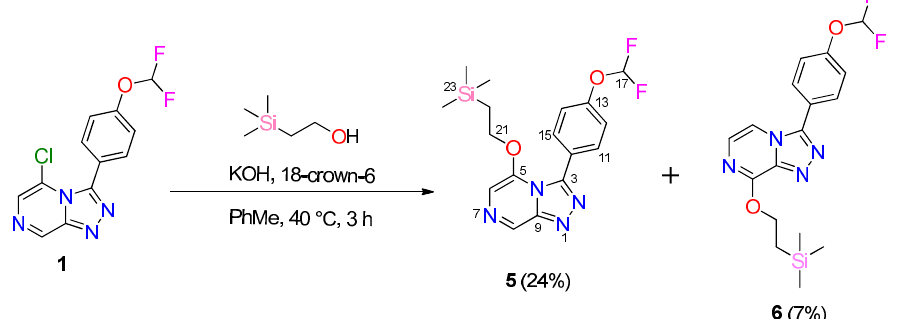
Figure 2. ORTEP drawing of compound 3 .